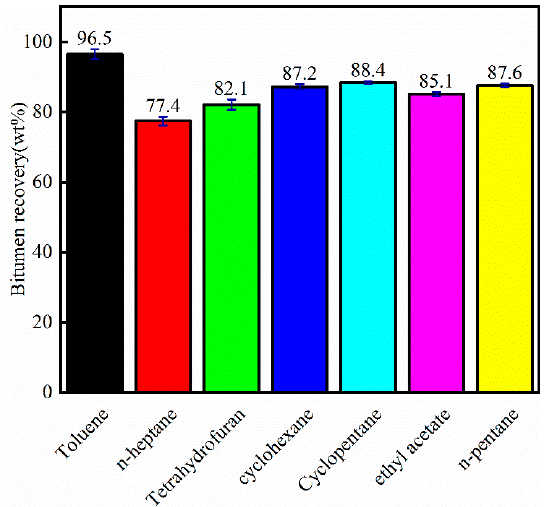
Figure 4. Final bitumen recovery by different solvents for crude bitumen samples.